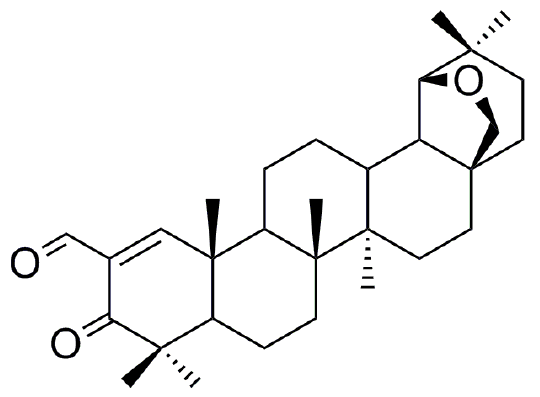
Figure 1. Chemical structure of semi-synthetic triterpenoid OA . The new compound with potential anticancer activity should be toxic against the cancer cells, with minimal damage being caused to normal human cells. In order to evaluate the selectivity of OA against cancer cells, the cytotoxicity of OA against HBL-100 and K562 cell lines and their Dox-resistant subclones was compared with its action against the non-cancerous human breast epithelial cell line MCF10A. The results are shown in